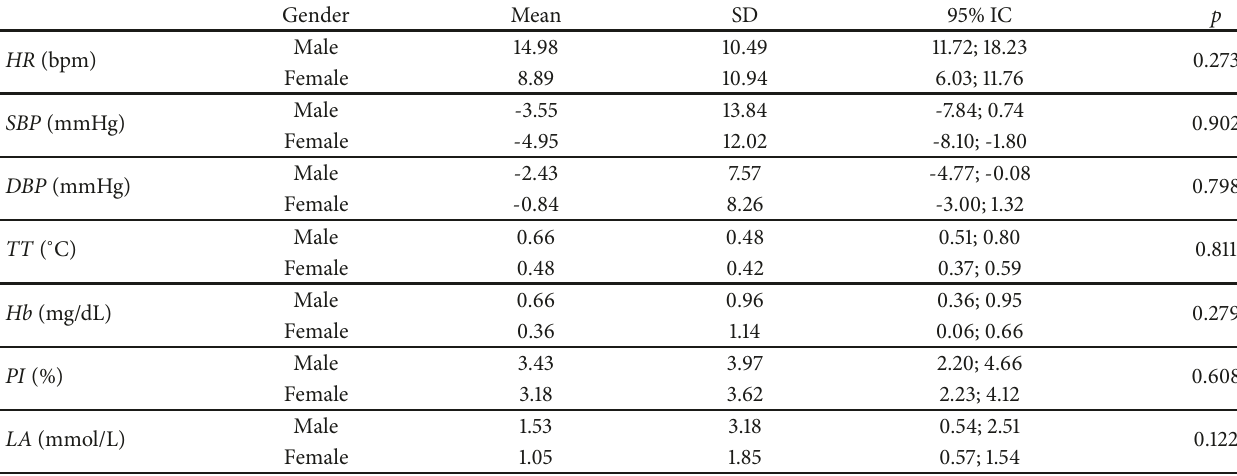
Table 5: Distribution of the means of the differences of the measured values and their confidence intervals according to tolerance and gender , as well as their statistical significance and 𝑝 values of the created models.